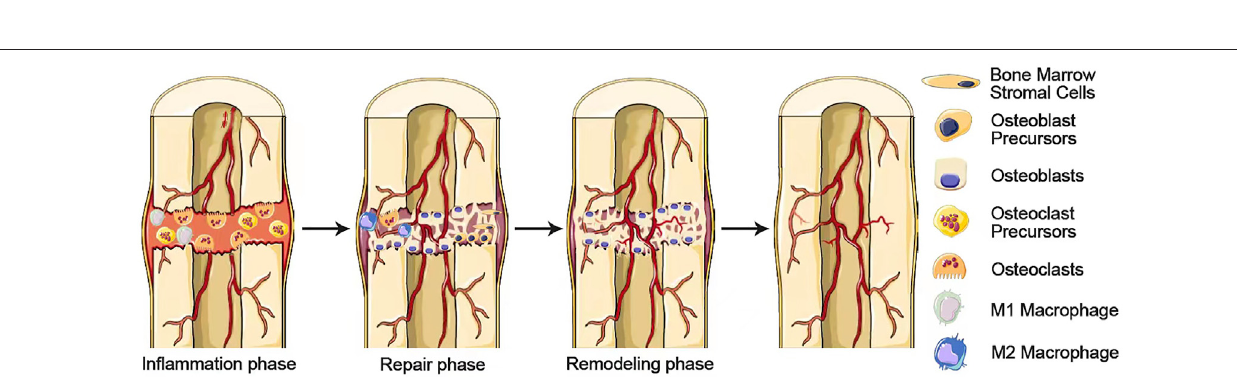
Frontiers in Bioengineering and Biotechnology |